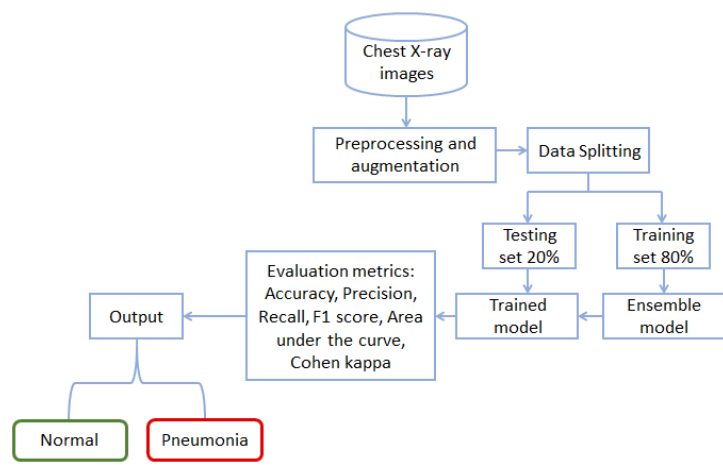
Figure 1. The workflow of the proposed